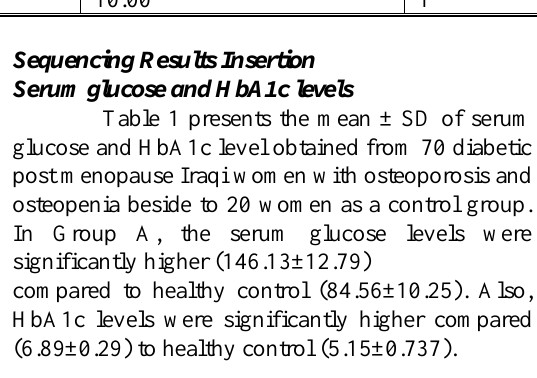
Statistical Analysis